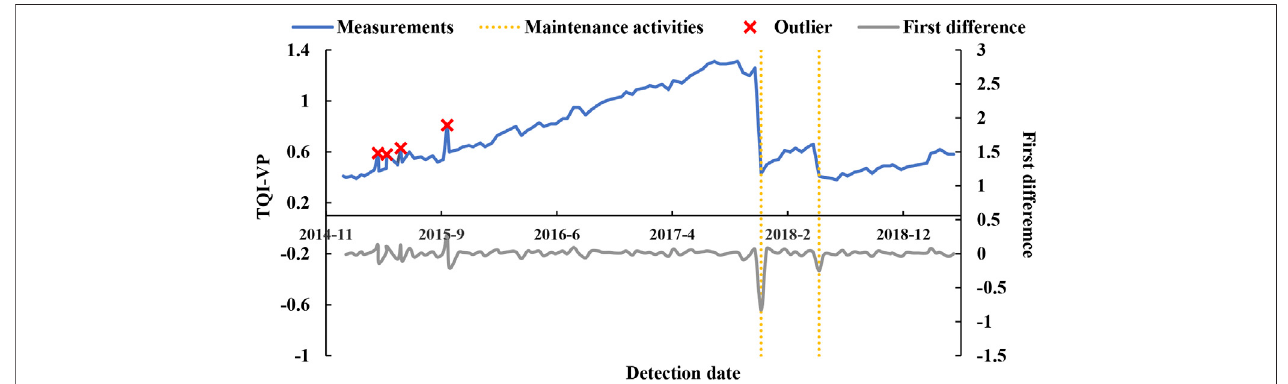
FIGURE 1 | The different characteristics of maintenance activities and contaminated measurement data.